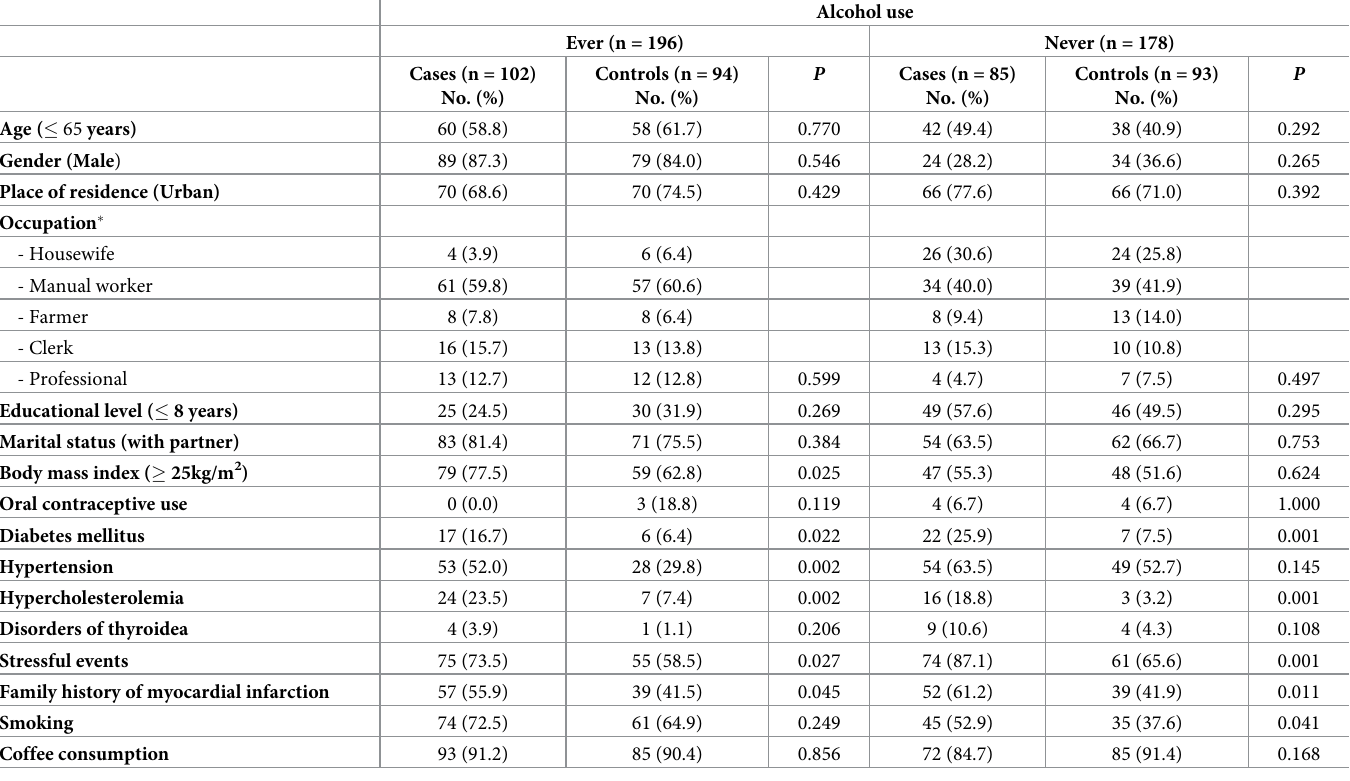
Table 2. Characteristics of patients with acute myocardial infarction and their controls, according to alcohol